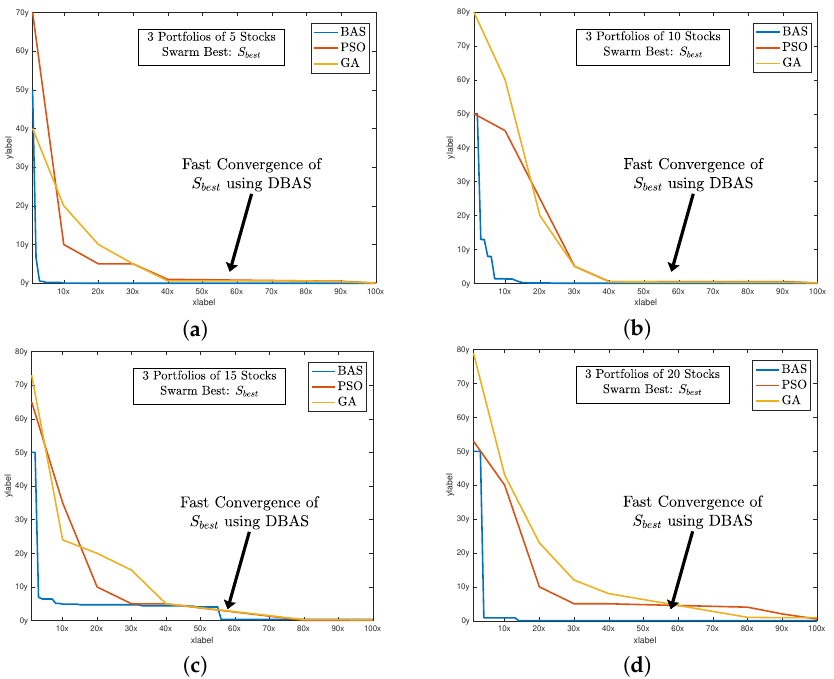
Figure 5. The sharp and fast convergence of DBAS swarm’s G best toward the minima while selecting optimal configuration of all 3 portfolios. It also shows the comparison with PSO and GA algorithms, and it can be seen that the convergence profile of DBAS is fast compared to others. ( a ) shows the global convergence profile of all algorithms. Likewise, ( b ) shows the convergence of BAS, PSO, and GA. And finally, ( c , d ) shows the convergence of 15 and 20 stocks of all three algorithms respectively.